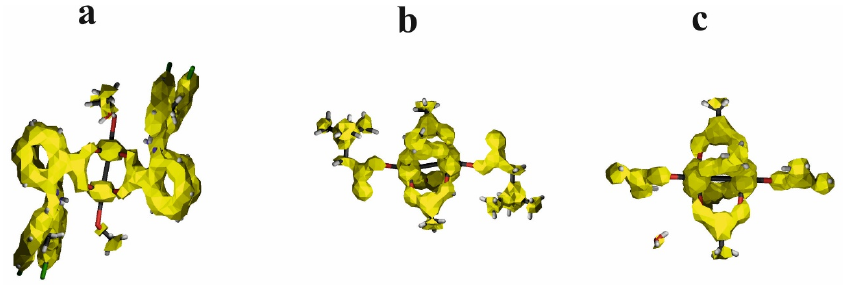
Figure 10. ACID surfaces for [Cu II 2 (Tolf) 4 (MeOH) 2 ] · 2MeOH ( a ), QEBQIX ( b ), and ACURCU01 ( c ). ACID field isosurfaces have been generated at the value of 0.05.